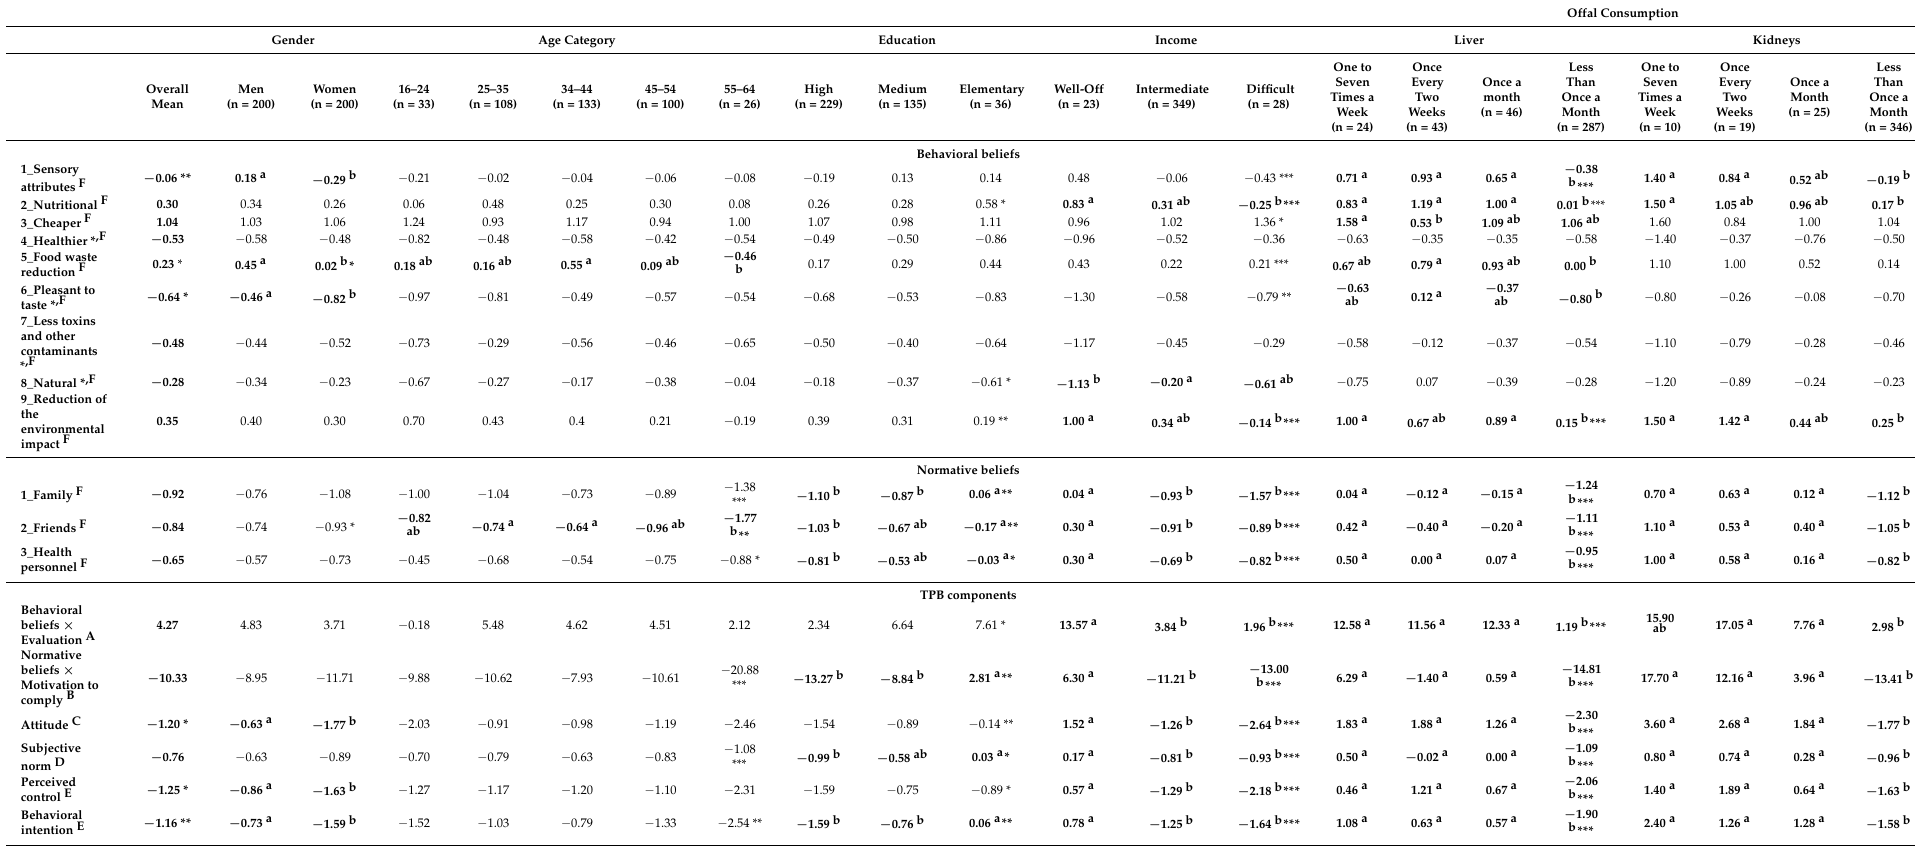
Table 2. Least squared means for the components of the model according to sociodemographic characteristics and offal consumption of the respondents ( N =